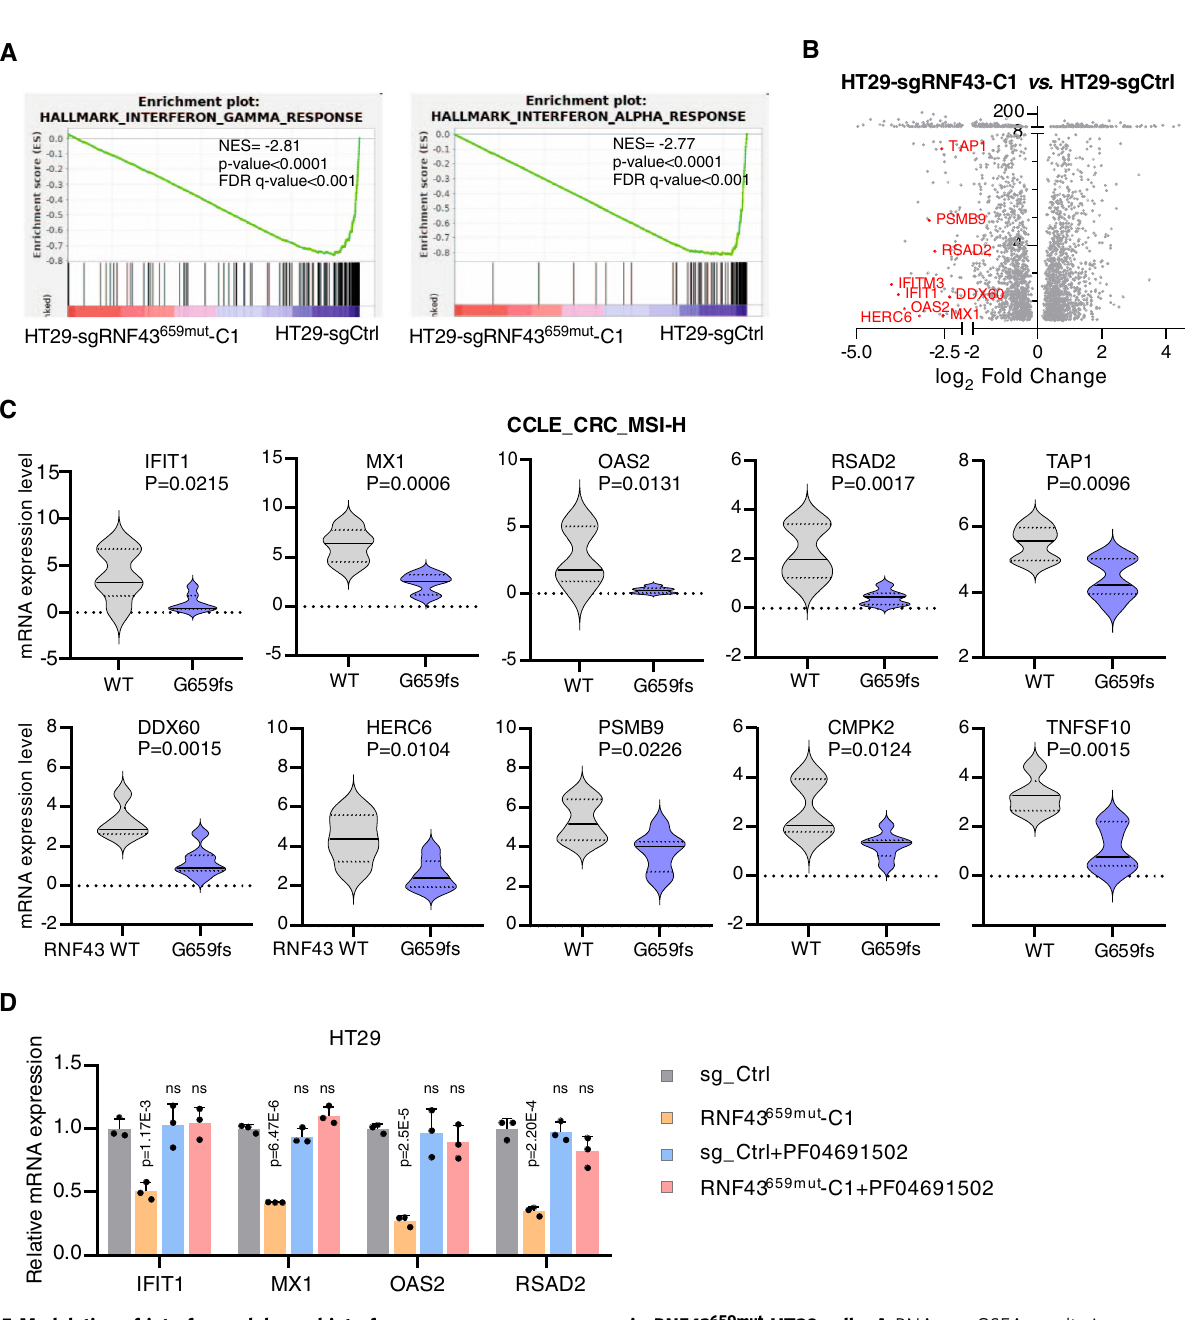
Fig. 5 Modulation of interferon alpha and interferon gamma response genes in RNF43 659mut HT29 cells. A RNA-seq GSEA results in HT29_ RNF43 659mut reveal decreased expression of interferon alpha and interferon gamma response genes. NES normalized enrichment score. B Volcano plot of differentially expressed genes in HT29_ RNF43 659mut vs. HT29_sgCtrl. Interferon alpha or gamma response genes are displayed in red. C Differential expression of interferon alpha or gamma response genes in G659fs vs. WT MSI-H CRC cell lines in the Cancer Cell Line Encyclopedia (CCLE). Two-sided t -tests were used to compare RNF43_WT ( n = 5) and RNF43_G659fs ( n = 7) cells. D Comparison of interferon response genes between HT29_sgCtrl and HT29_ RNF43 659mut -C1 before and after treatment with PF-04691502. Data are the mean ± SD. Two-sided Student ’ s t test ( n = 3 independent experiments in triplicate). Source data are provided as a Source Data fi (Supplementary Fig. 1a). Single colonies were selected by serial dilution and screened for frameshift mutations by Sanger sequencing of the PCR products generated using the primers that fl anked the targeted site (Supplementary Fig. 1b). Editing ef fi ciency was assessed by determining the percentage of sequences with frameshift mutations compared to the total number of polymers sequenced. The gDNA PCR primer sequences corresponding to the regions targeted by indicated sgRNAs are shown in Supplementary Table 4.